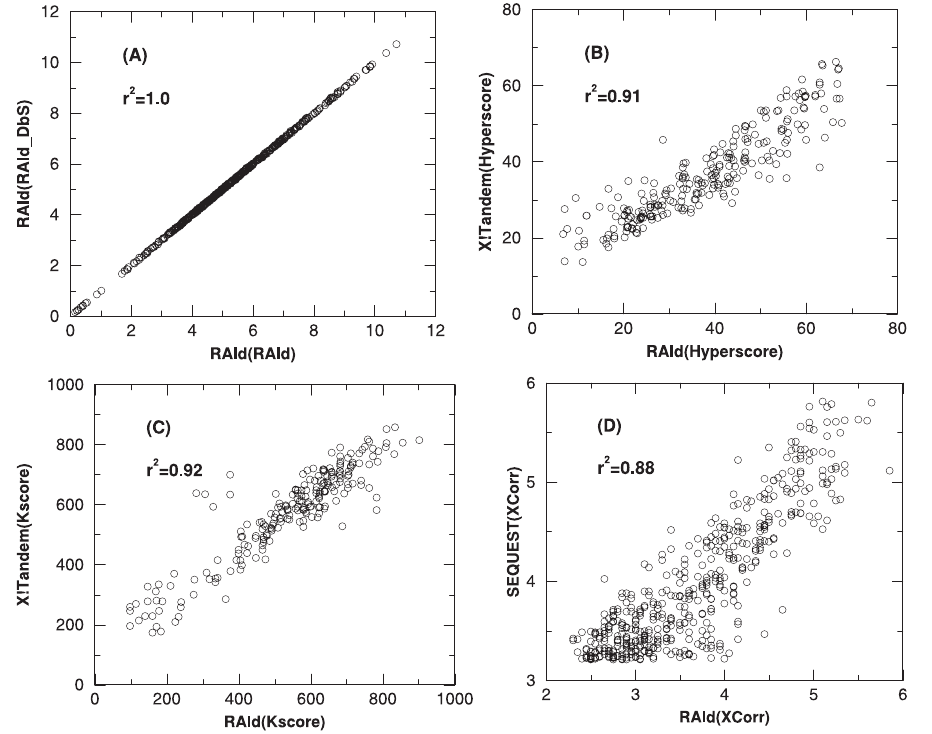
Figure 4. Score correlations. A subset of the ISB centroid data set [28] was used to perform this evaluation. For each scoring function, when the best hit per spectrum (analyzed using the analysis program that the scoring function was originally used for) is a true positive, that candidate peptide is scored again using the corresponding scoring function implemented in RAId_aPS. Each true positive best hit thus gives rise to two scores and plotted using the following rule: the first score is used as the ordinate while the second score (from RAId_aPS) is used as the abscissa. Including 500 spectra, panel A is for the RAId score. Panel B is for Hyperscore and contains 248 spectra. The result of K-score is shown in panel C with 220 spectra. Shown with 500 spectra, panel D documents the results for XCorr.